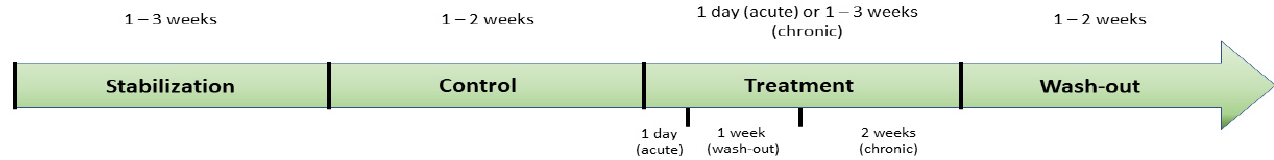
Figure 3. Timetable of acute and chronic experiment.